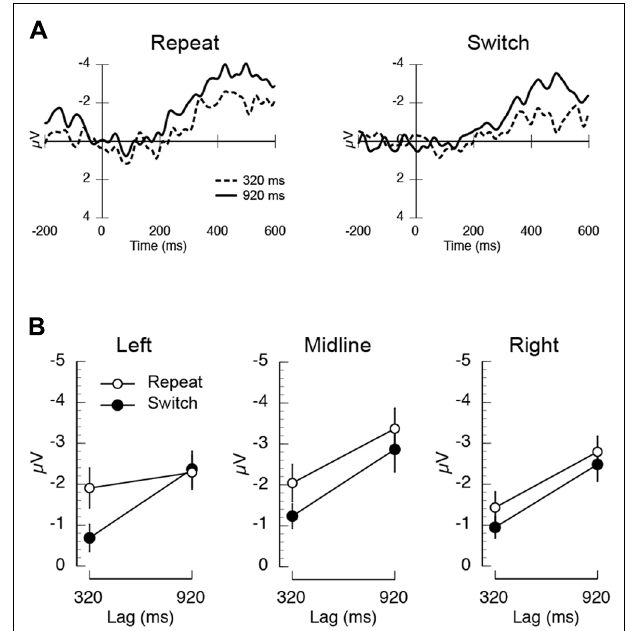
FIGURE 4 | Results of the control analysis of the electrophysiological data from Experiment 2 using a 50 ms prestimulus baseline . (A) Mean unrelated-related differences waves illustrating the N400 measured at central electrodes (average at electrodes C3/Cz/C4). (B) Mean N400 amplitude measured at left (F3/C3/P3), midline (Fz/Cz/Pz), and right electrodes (F4/C4/P4) plotted as a function of inter-trial dependency (repeat/switch) and lag (320/920